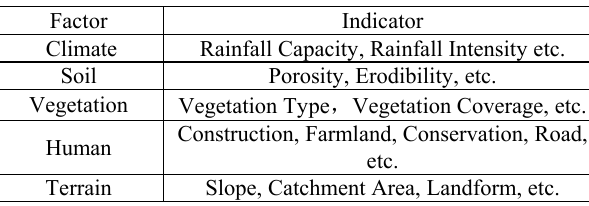
Table 1. Main influence factors on soil water erosion in the loess plateau of China conducted by Wang et al.